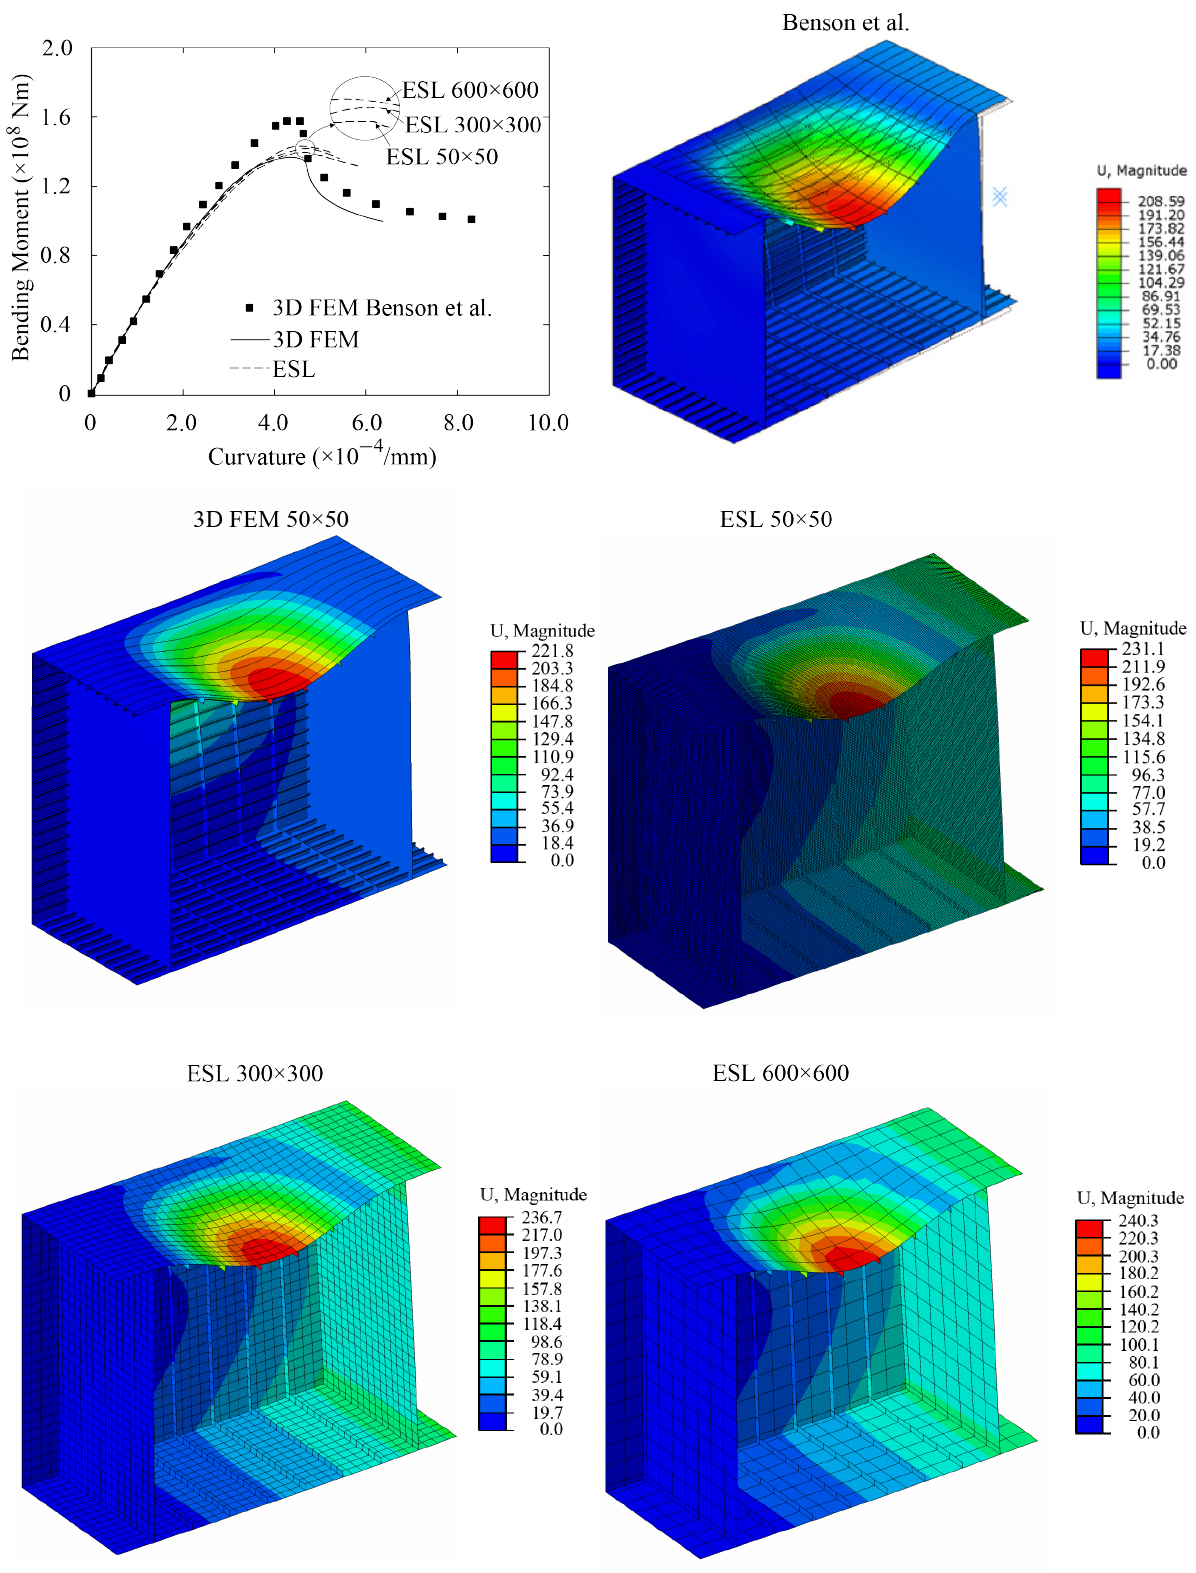
Figure 5. Bending moment–curvature curves and deformation shapes obtained from Benson et al. [14], 3D FEM and ESL models. U is in